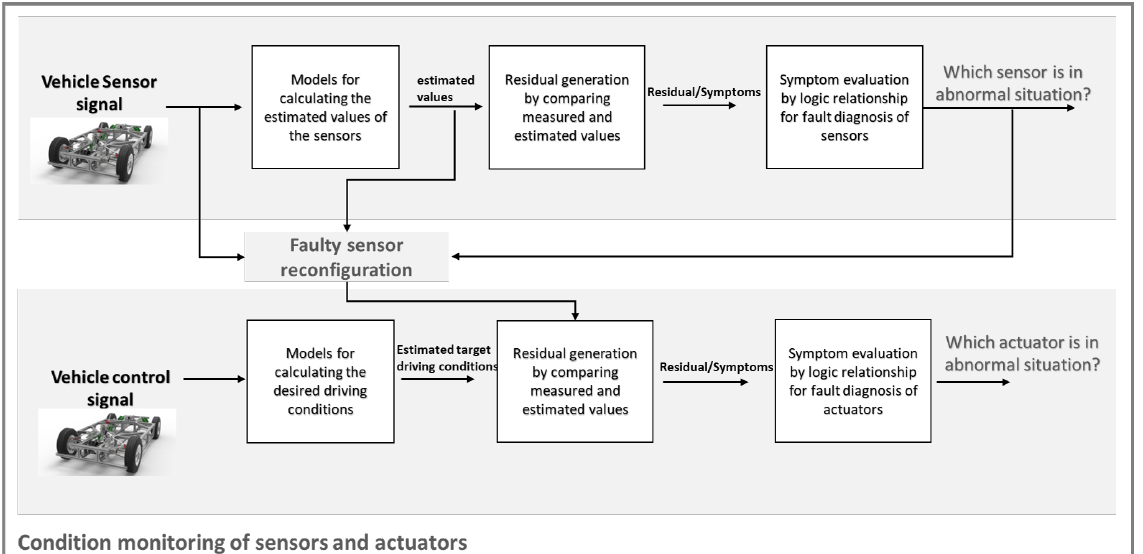
Figure 1. Scheme of condition monitoring of sensors and